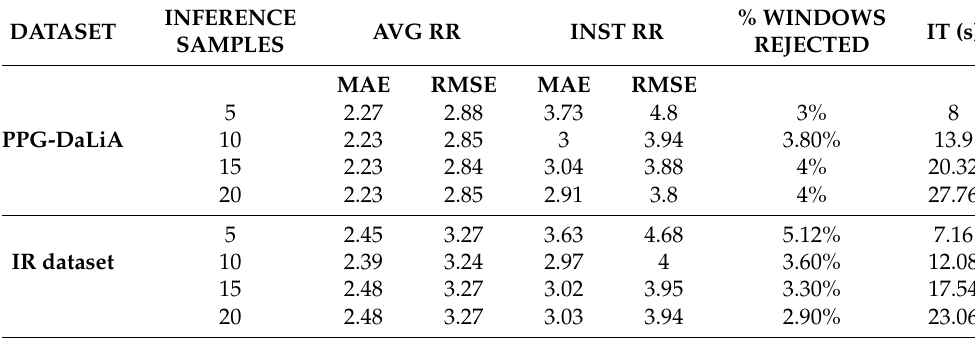
Table 3. Description of trade-off between the number of inference samples, number of uncertain windows rejected, and the inference time consumed.